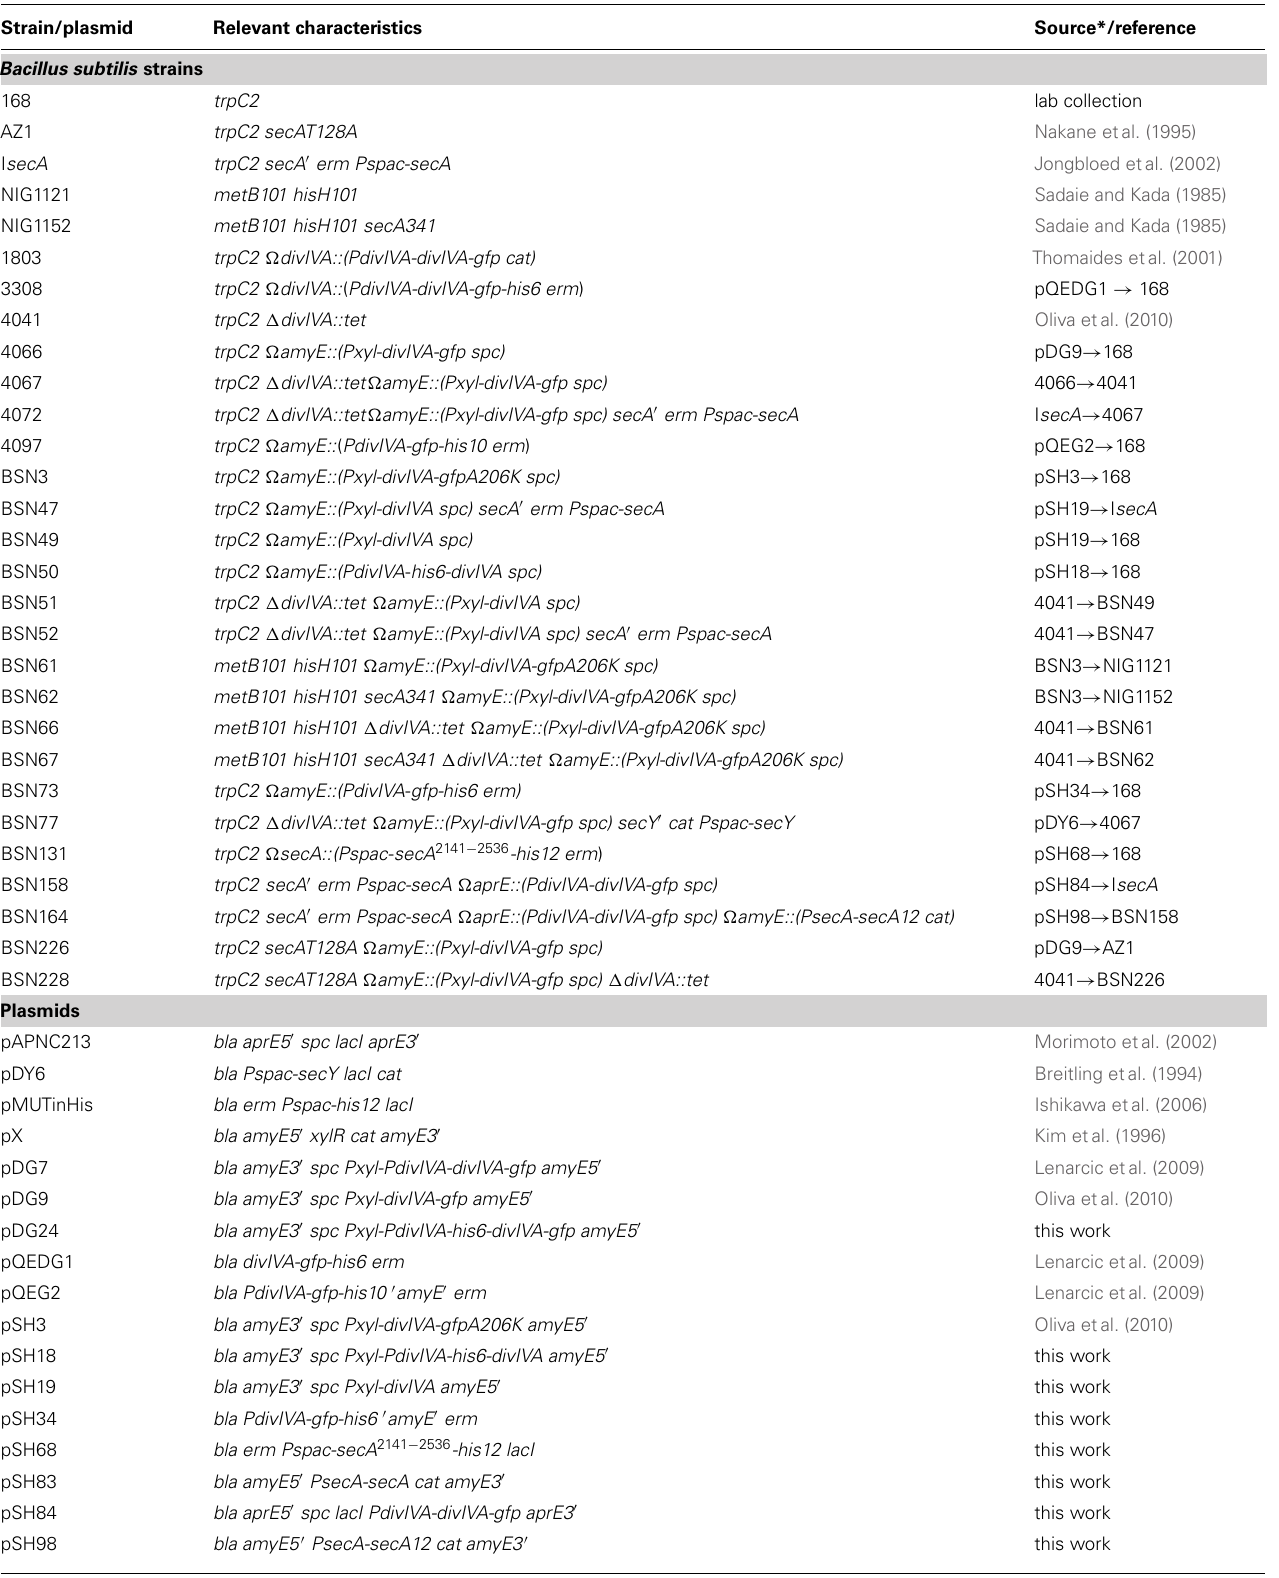
*The arrow ( → ) indicates a transformation where the donor and the recipient are given on the left and the right side of the arrow,